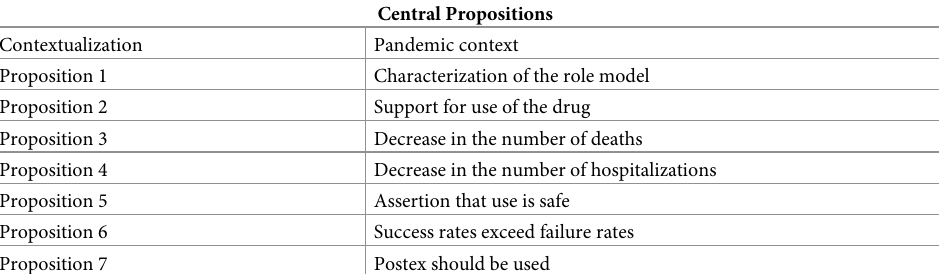
Table 2. Central propositions used in the story texts for the experiments on recall and transmission of informa- tion about COVID-19.